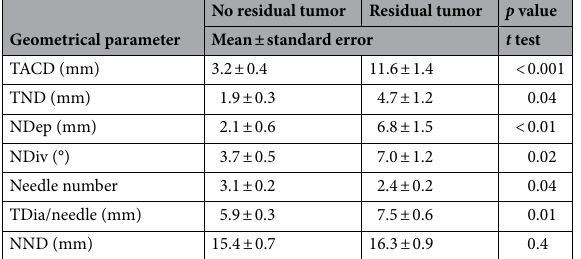
Geometrical parameter